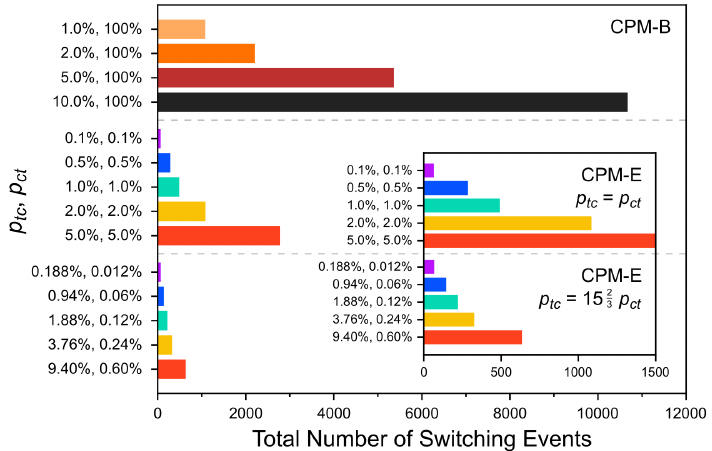
Figure 9. Total number of photoisomerization events (forward and backward) throughout each simulation (over 500 cycles) for different switching probabilities in the CPM-B and CPM-E approach. The inset zooms in on the number of switching events in the CPM-E